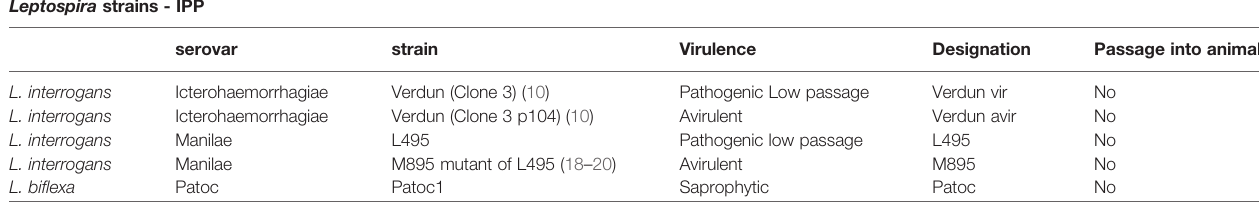
TABLE 1 | Leptospira strains used for DCs challenge at the Institut Pasteur in Paris (IPP) and at the Institut Pasteur of New Caledonia (IPNC). Leptospira strains - IPP